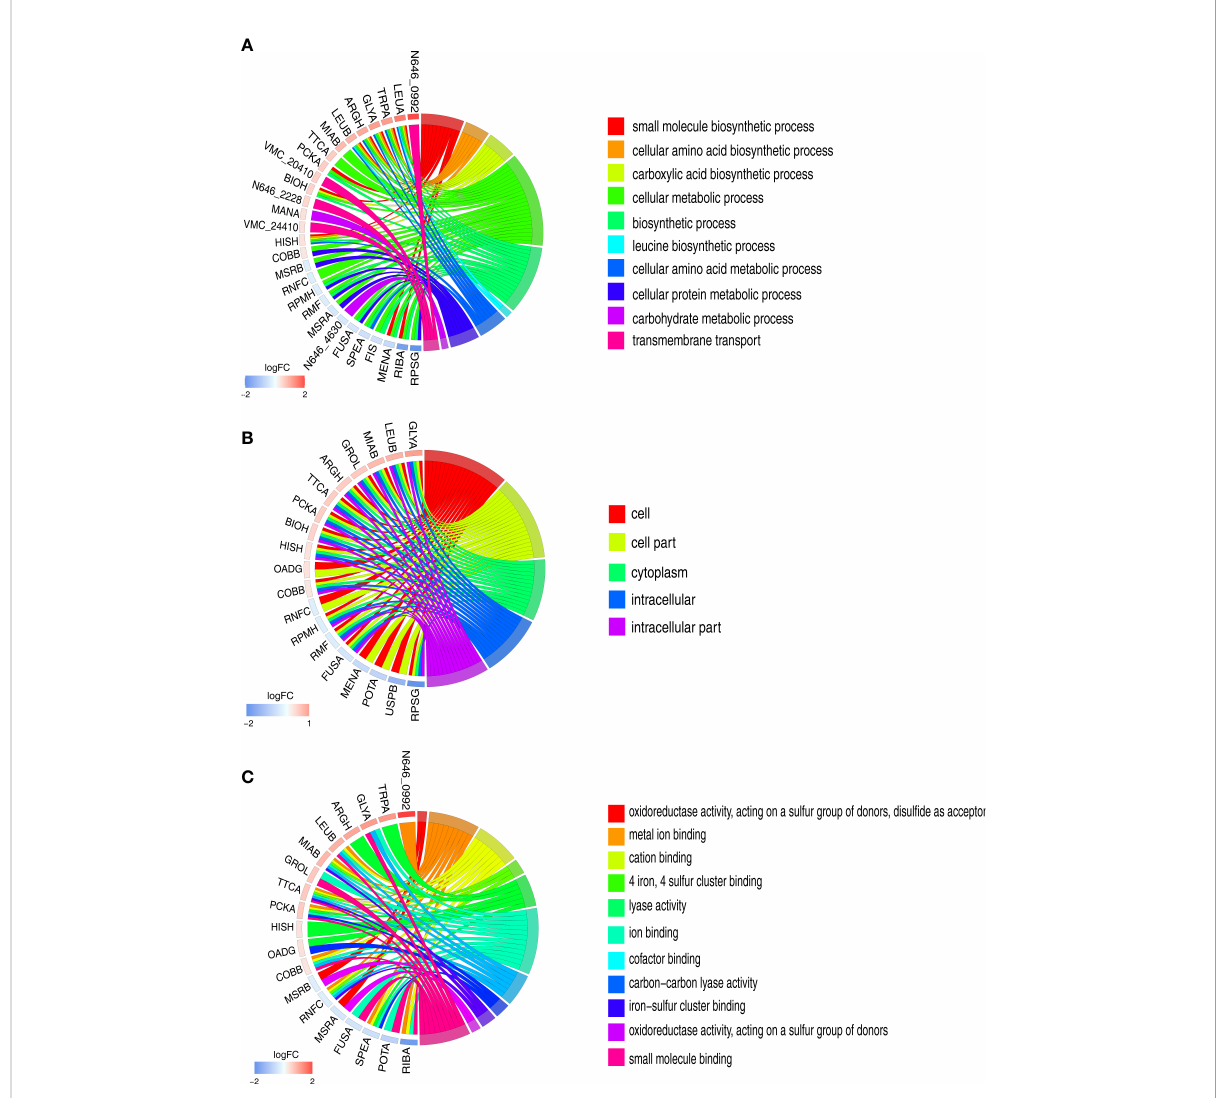
FIGURE 3 Gene Ontology (GO) term enrichment analysis of differentially expressed proteins. (A) Chord chart analysis of GO annotation in biological processes. (B) Chord chart analysis of GO annotation in cellular component. (C) Chord chart analysis of GO annotation in molecular functions. The left side of the GO Chord displayed whether the gene was up- or down-expression. Red represents up-expression genes and blue represents down-expression. The right side represents different GO terms with different colors. A gene was linked to a certain GO term by the colored